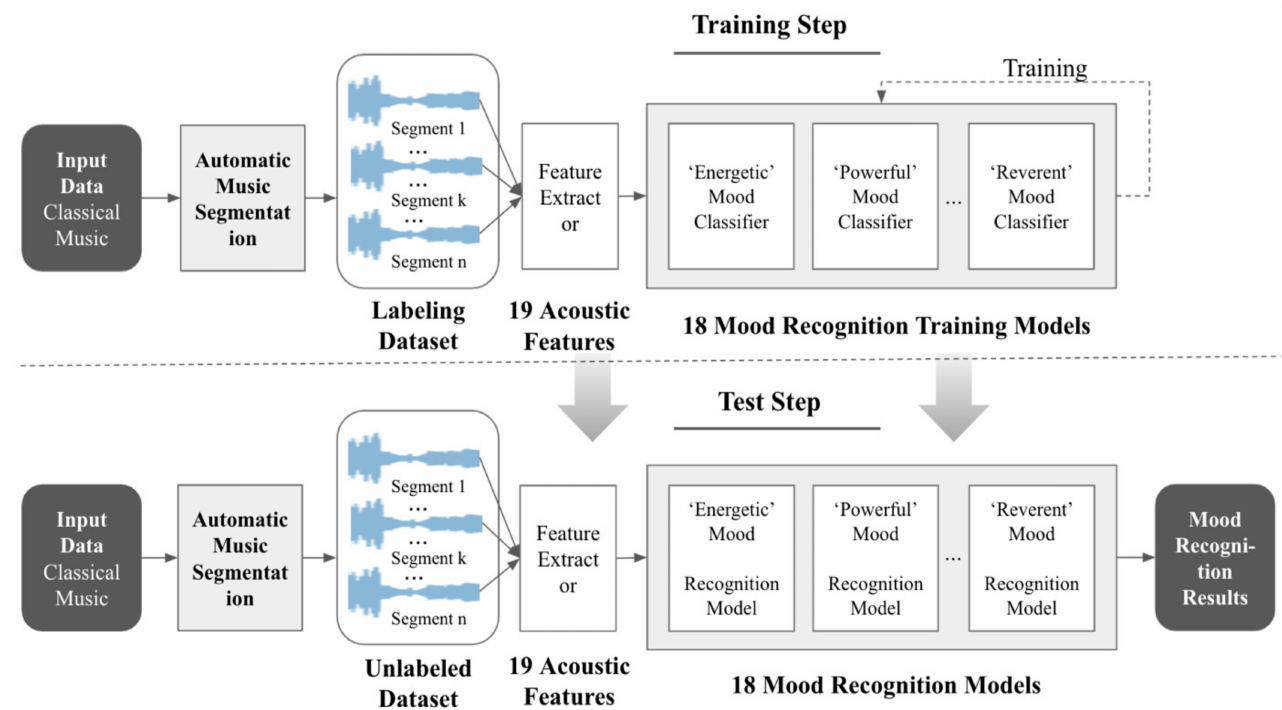
Figure 8. Classical Music Mood Recognition